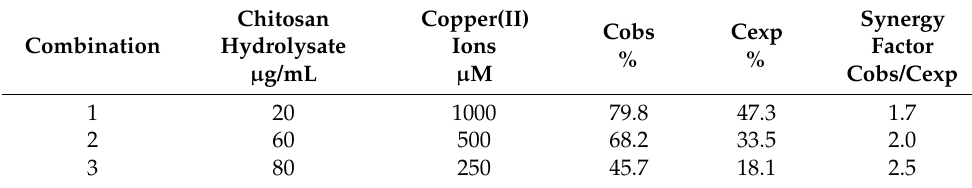
Table 3. Synergistic activity calculation via Abbott’s formula. The synergy factor SF is the ratio of the observed inhibition Cobs to the expected inhibition Cexp, with synergistic activity shown by SF > 1.